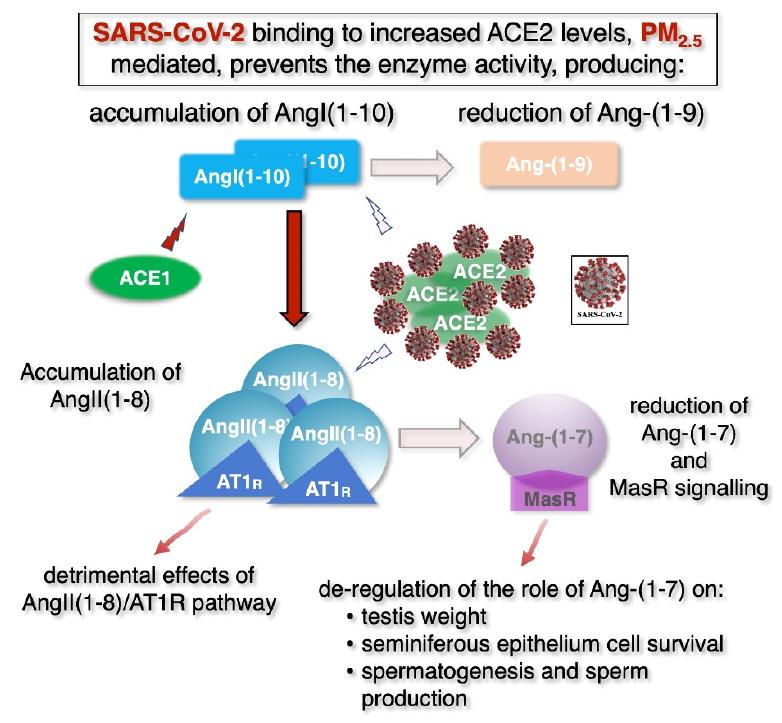
Figure 4. Speculative model of synergistic action of PM2.5 and SARS-CoV-2 on the renin-angiotensin pathway in male reproductive system. In polluted areas, high levels of PM2.5 may produce harmful synergistic effects with a SARS-CoV-2 infection. See text for details. Lighter colors indicate reduced amounts of the indicated molecules and extent of the enzymatic reaction (arrows), respectively.